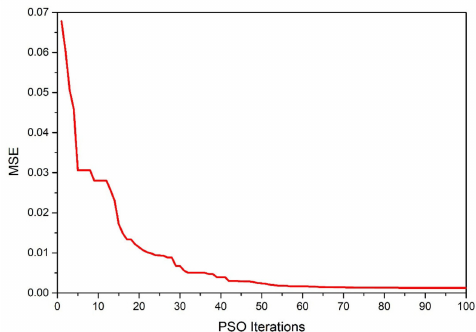
Figure 7. Relationship between the particle swarm optimization (PSO) iterations and mean-square error (MSE).